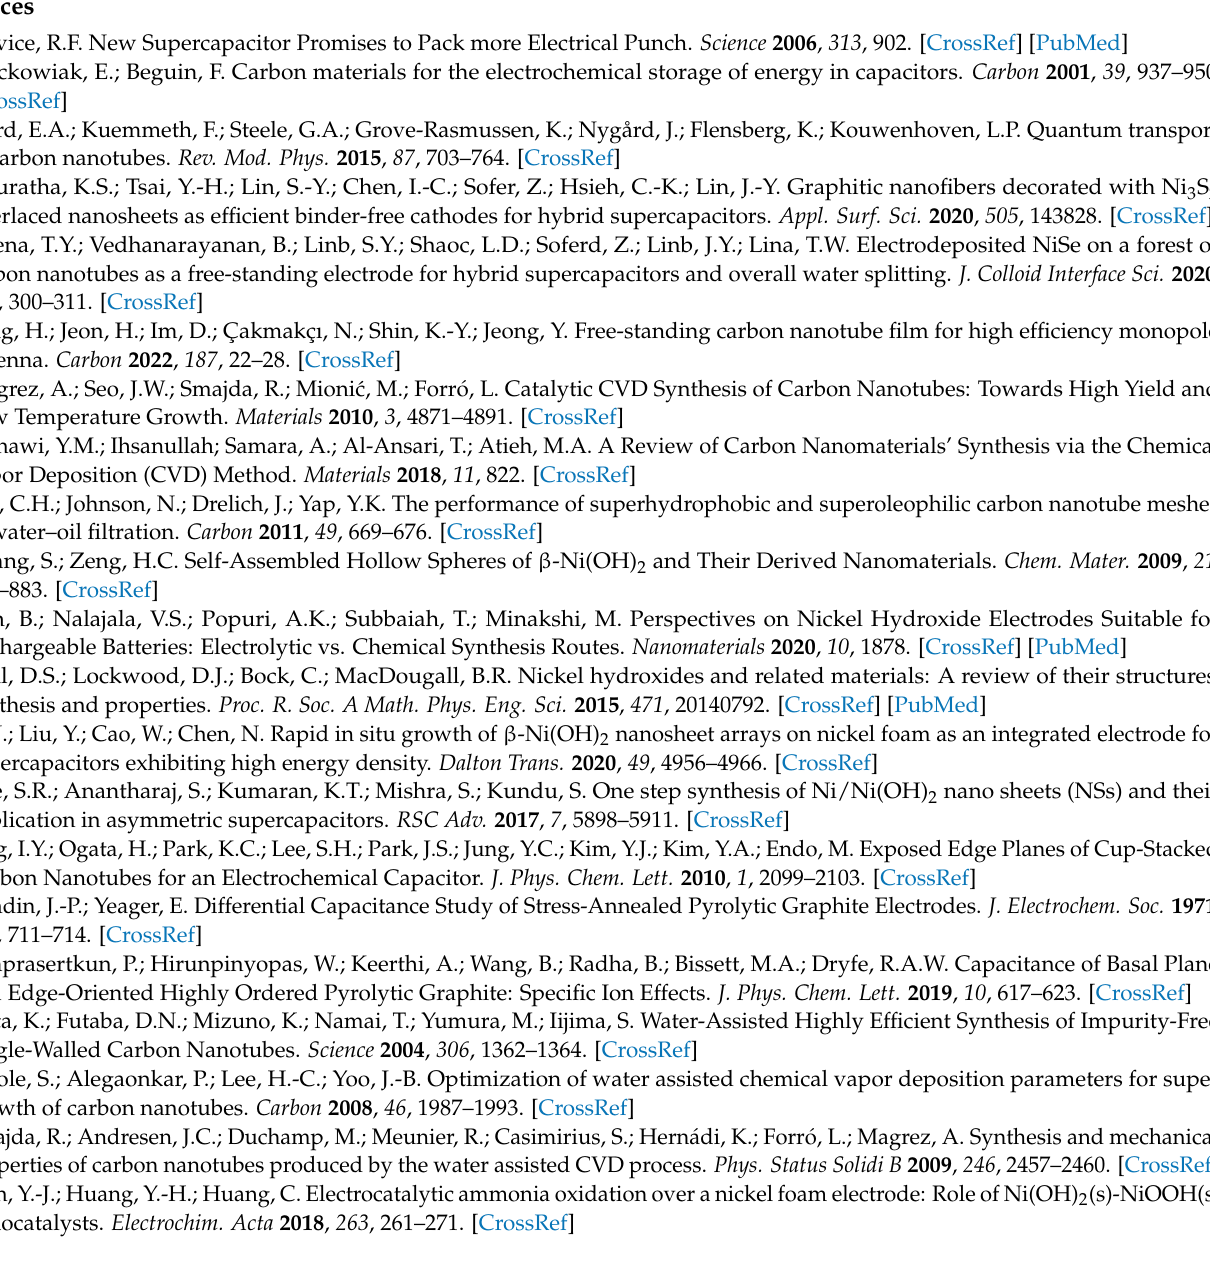
Table S2: The C S values and C S retentions in two-electrode configuration, with increasing 100 times of CV scan rates and GCD current densities; Table S3: Comparison of the areal specific capacitance of carbon-based nanomaterials/NF electrode. References [28–31] were cited in the Supplementary